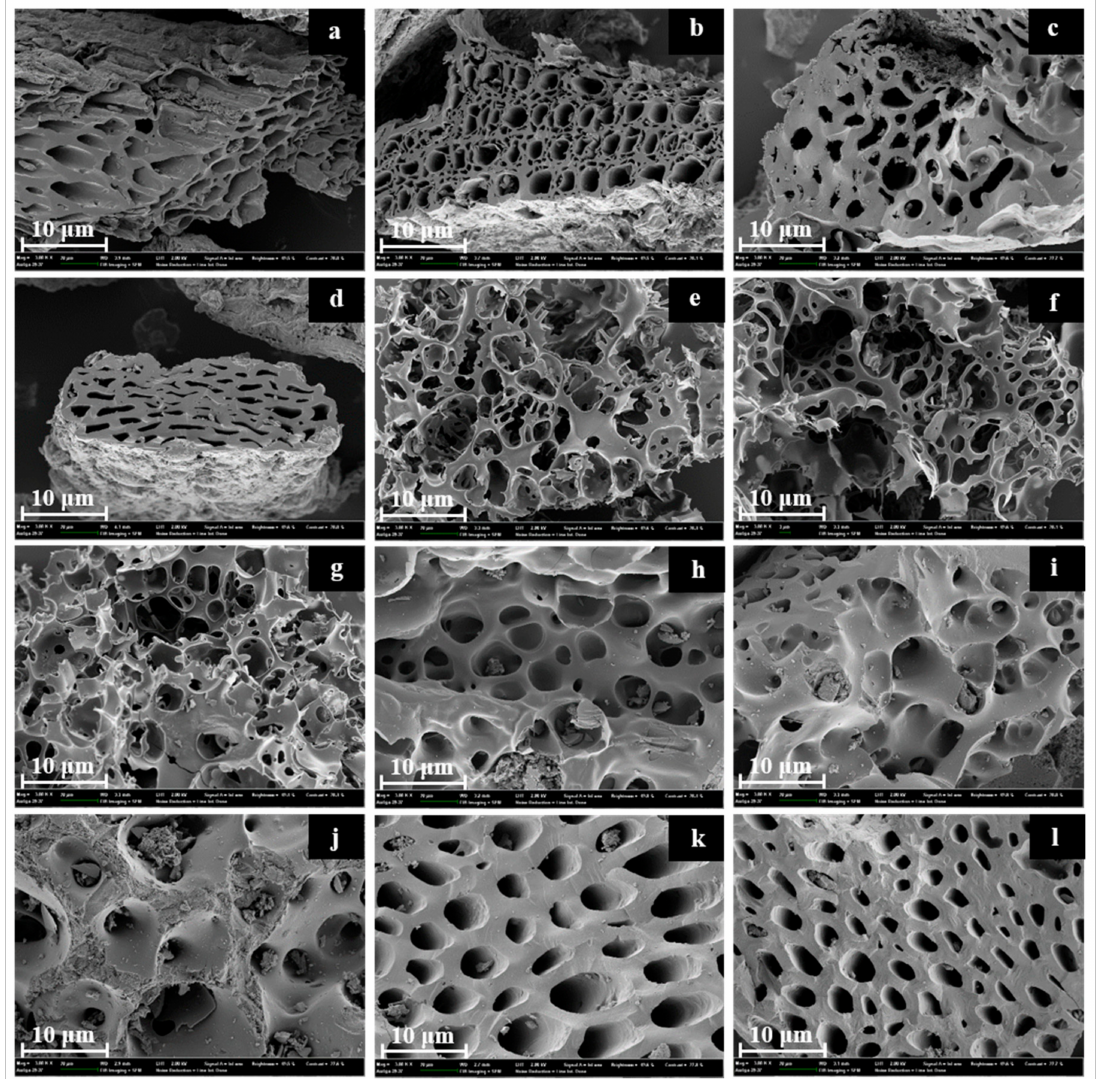
Figure 6. SEM image of empty fruit bunch activated carbon prepared at different temperatures 600 ◦ C, 700 ◦ C and 800 ◦ C. ( a – c ); EFBAC, ( d – f ); EFBACK, ( g – i ); EFBACZ, and ( j – l ); EFBACP, respectively (the SEM image of activated carbon prepared using a mixing ratio of activating agent of 1:1 is not included in this